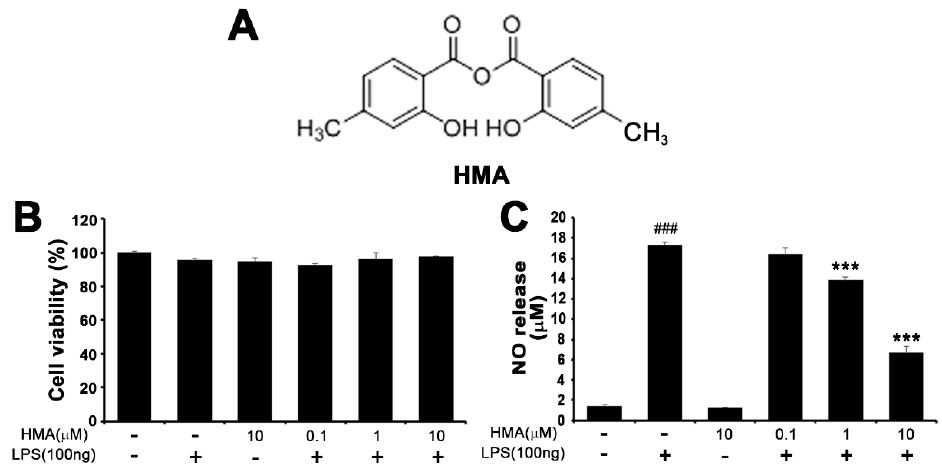
Figure 1. Effect of 2-hydroxy-4-methylbenzoic anhydride (HMA) on the BV-2 microglial cell viability and nitric oxide (NO) release. ( A ) The structural formula of HMA; ( B ) For cell viability, BV-2 cells were pretreated with HMA alone (10 µ M) and at various concentrations (0.1, 1.0, and 10 µ M) for 1 h, followed by lipopolysaccharide (LPS) treatment (100 ng / mL) for 24 h. Cell viability was measured using the MTT assay; ( C ) NO release was evaluated using culture media in the Greiss assay. Data are mean ± S.E.M. ( n = 6). ### p < 0.001 as compared with control group and *** p < 0.001 as compared with LPS-treated group by one-way ANOVA ( C ) F(5,30) = 306.1, p < 0.0001)).